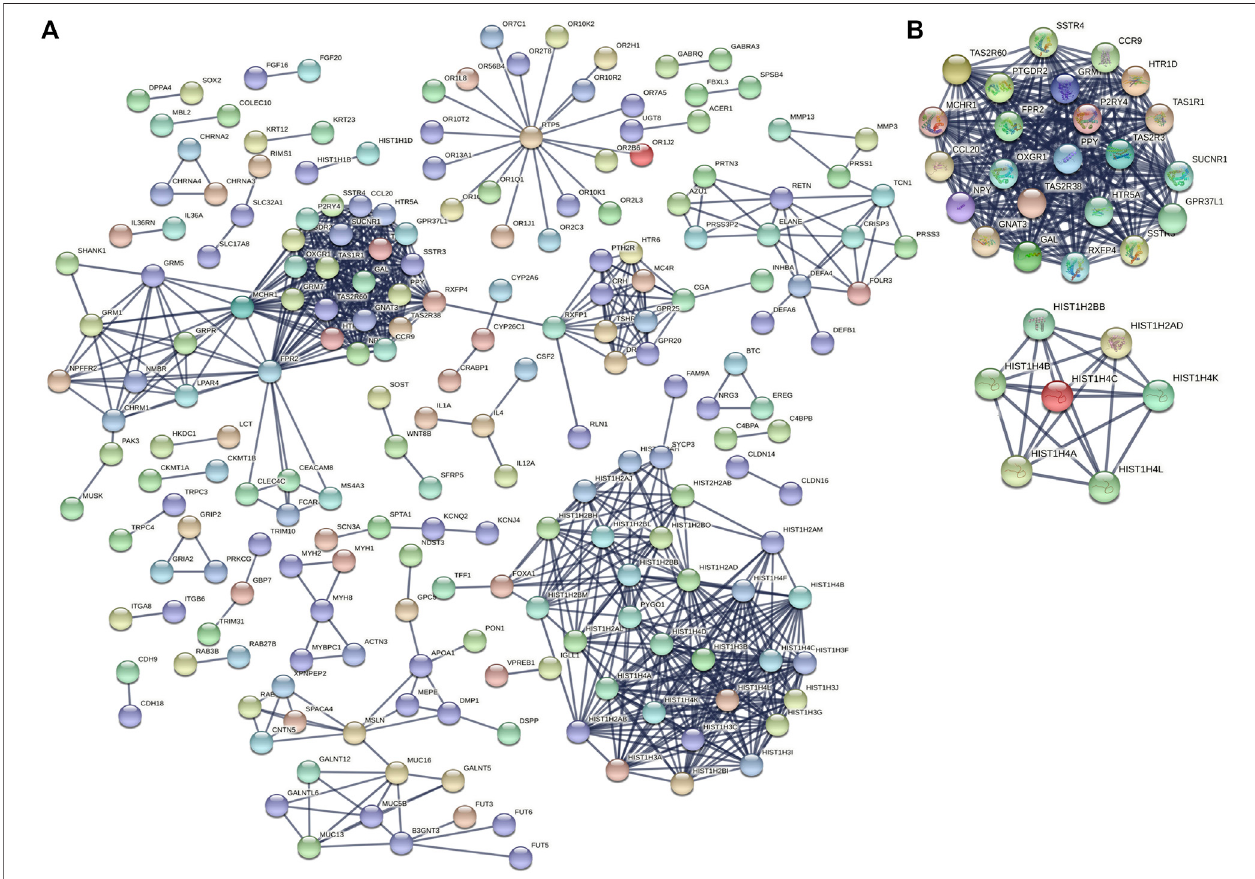
FIGURE5| PPInetworksandhubgenesbasedonDEGsbetweenimmunotypesAandBinTHYM. (A) PPInetworksbasedonDEGsbetweenimmunotypesAand B in THYM. (B) Hub genes based on PPI network in THYM.